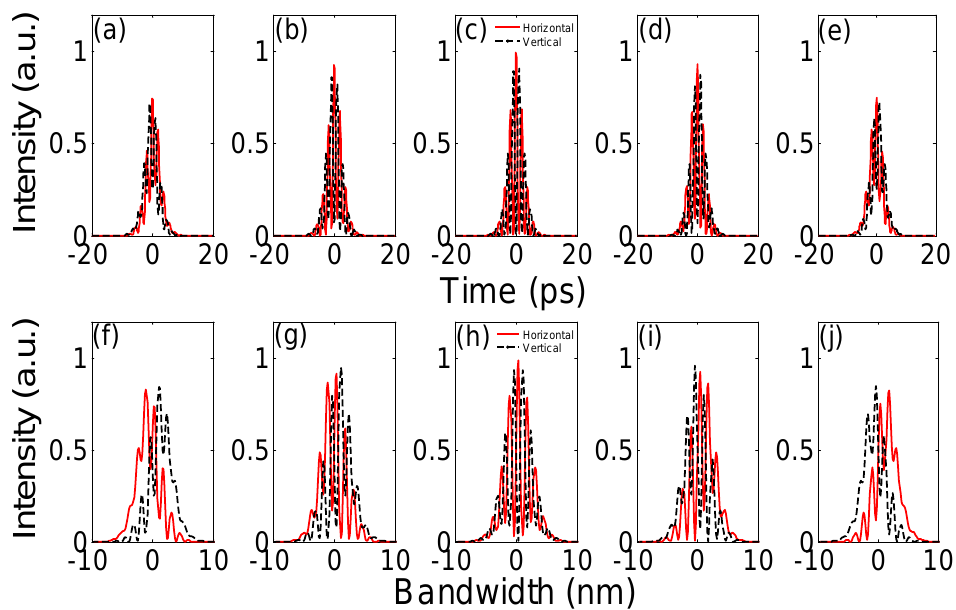
Figure 8. Theoretical results after polarization splitting when projection angle is changed and λ 1 = 1063 nm, λ 2 = 1065 nm.